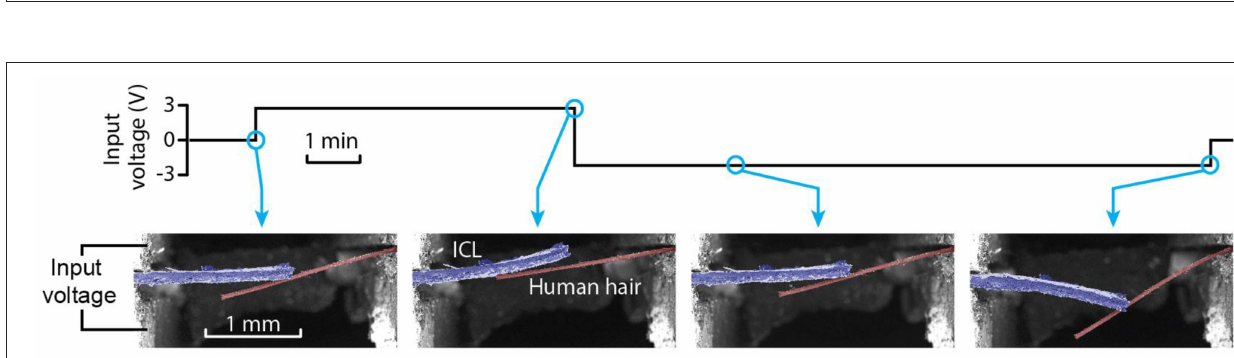
take advantage of the uniform and widely distributed nature of textiles that have a well-defined structure in the mm-scale, but span in meters in two dimensions.